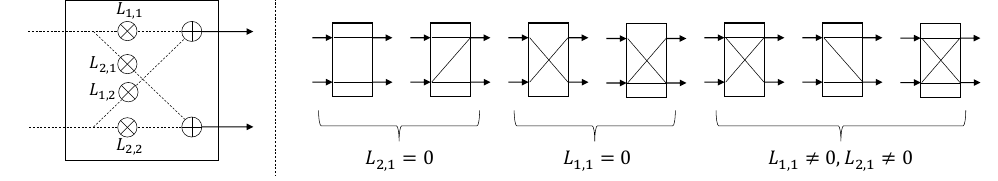
Figure 3: Seven Patterns of Linear